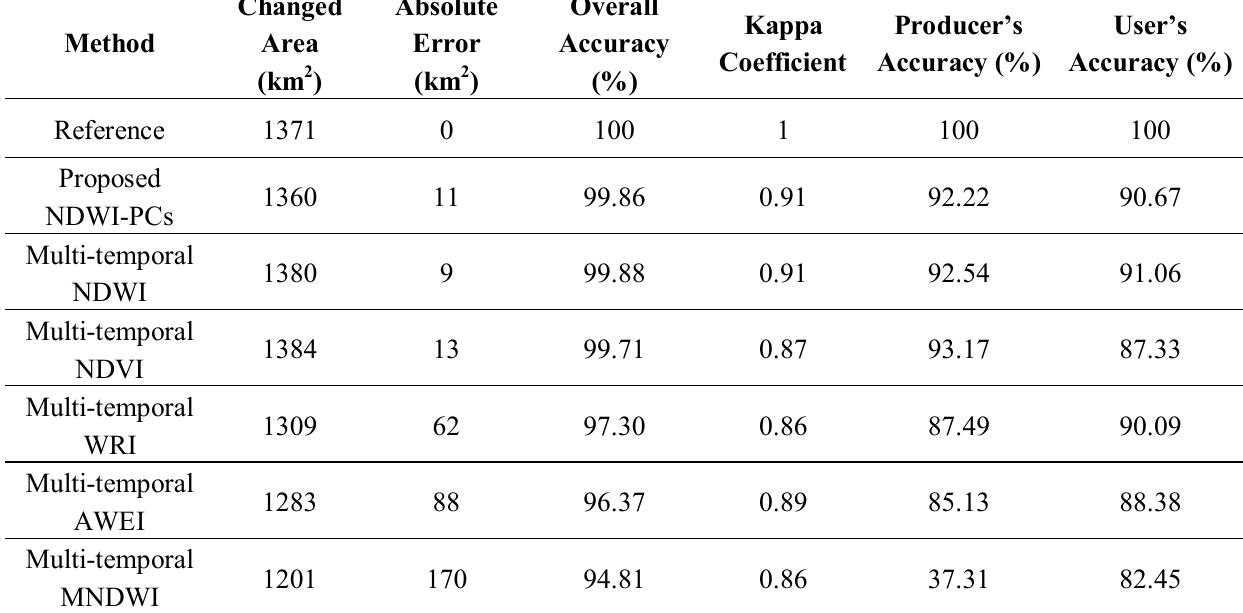
Table 7. Statistics of Lake Urmia surface area change between 2000 and 2010, and accuracy assessment